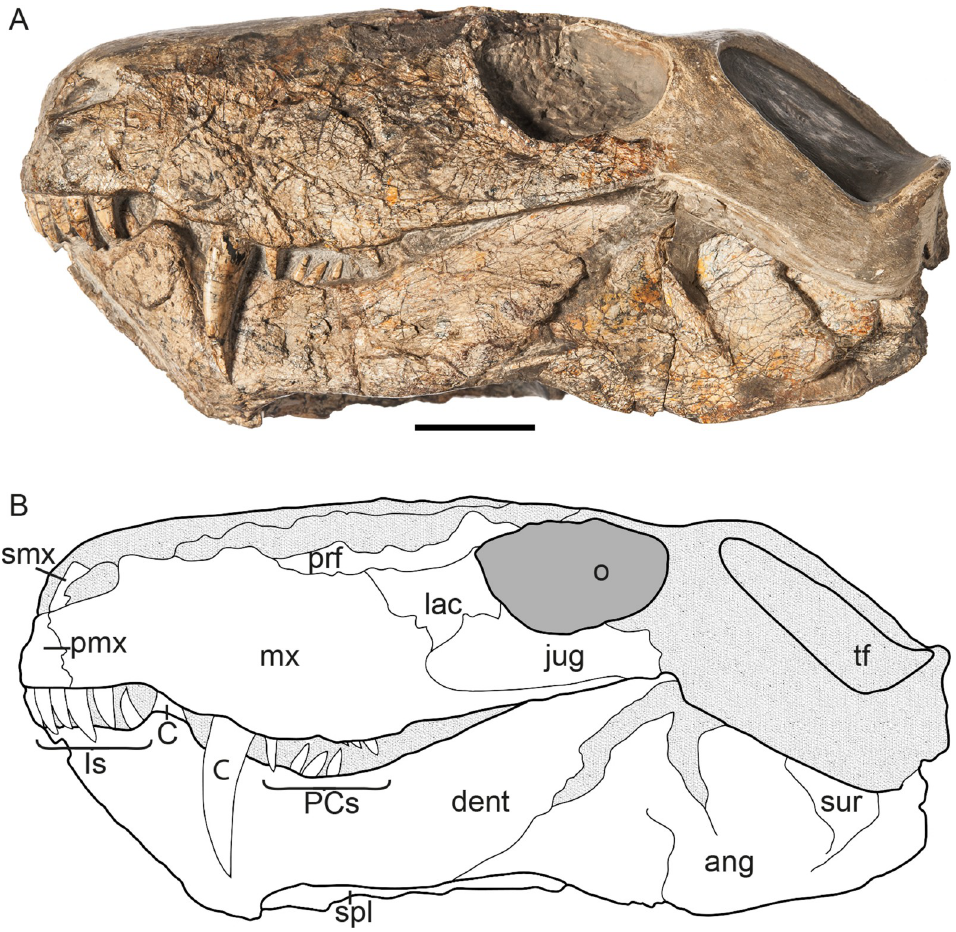
Fig 1. MB.R.999, (A) photograph (reprinted [22] under a CC BY license, with permission from Carola Radke, MfN, original copyright 2016) and (B) interpretative drawing of specimen in left lateral view. Abbreviations: ang, angular; C, canine; dt, dentary; Is, incisors; jug, jugal; lac, lacrimal; max, maxilla; o, orbit; PCs, postcanines; pmx, premaxilla; prf, prefrontal; smx; septomaxilla; spl, splenial; sur, surangular. Scale bar = 2